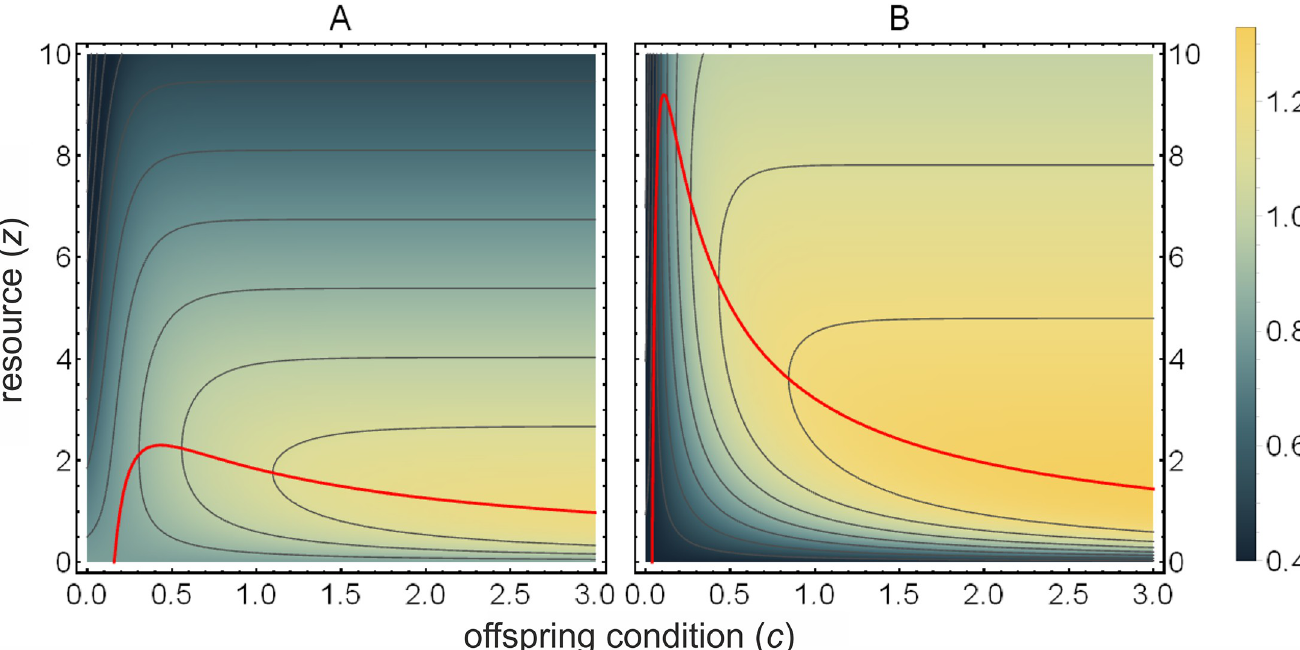
Fig 2. Inclusive fitness depending on offspring condition c and parental investment z . (A) Parental fitness (function u according to Eq 2 without signal cost f ( x )). (B) Offspring fitness (function v according to Eq 1 without signal cost f ( x )). Red line connects the equilibrium z values where ~ z ¼ ln g Uc Z = 10, G = 0.08, U = 1, γ = ½ , ψ = ½